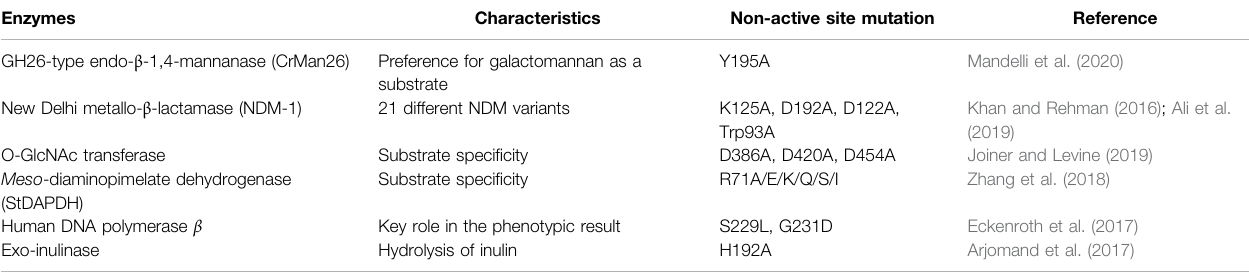
TABLE 1 | Research on understanding catalytic mechanisms of non-active